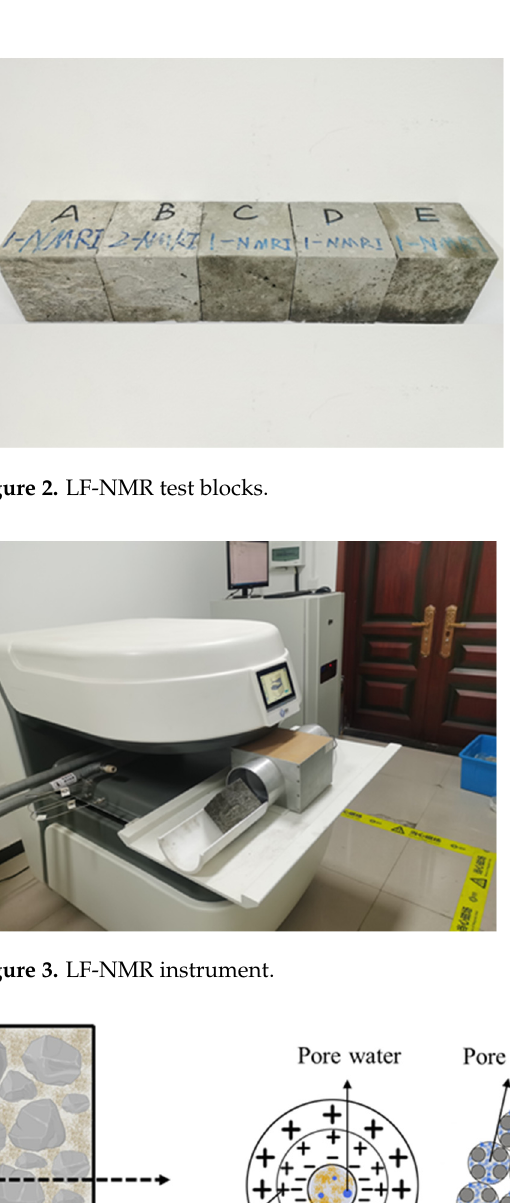
Figure 4. Classification of water forms in concrete.